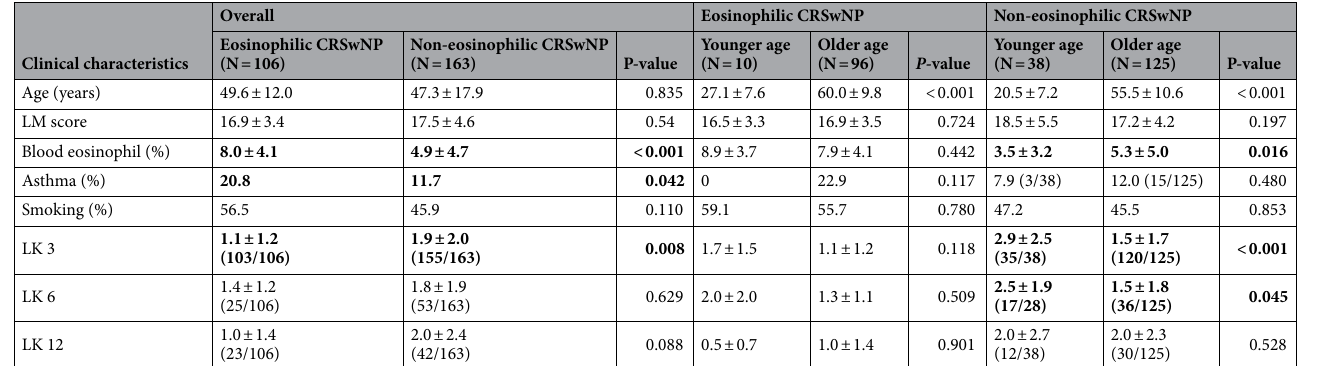
Table 1. Characteristics and treatment outcome. CRSwNP: chronic rhinosinusitis with nasal polyps, LM: Lund Mackay, LK: Lund Kennedy. The results for continuous variables are presented as means with standard deviations. The age cut-off was 35 years. Values in brackets indicate the proportion of patients who were checked for postoperative outcomes. Significance values are in